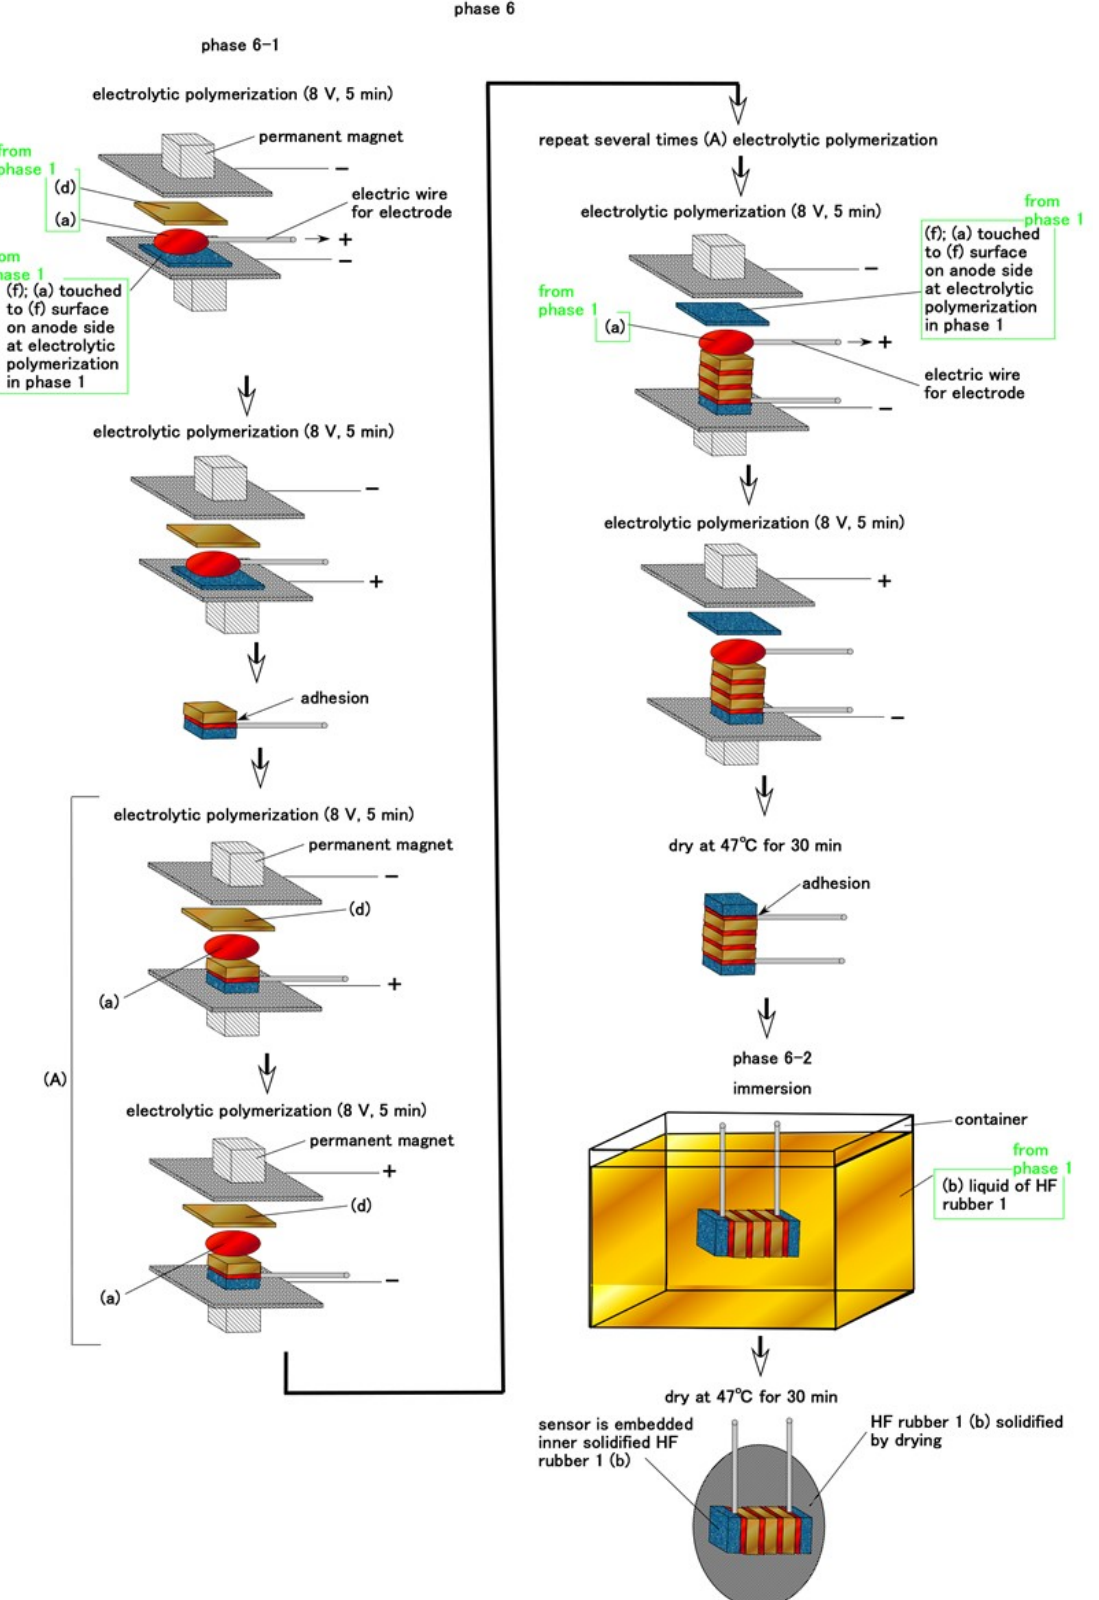
Figure 8. Schematic of the fabrication of Pacinian corpuscle cutaneous receptors during Phase 6.